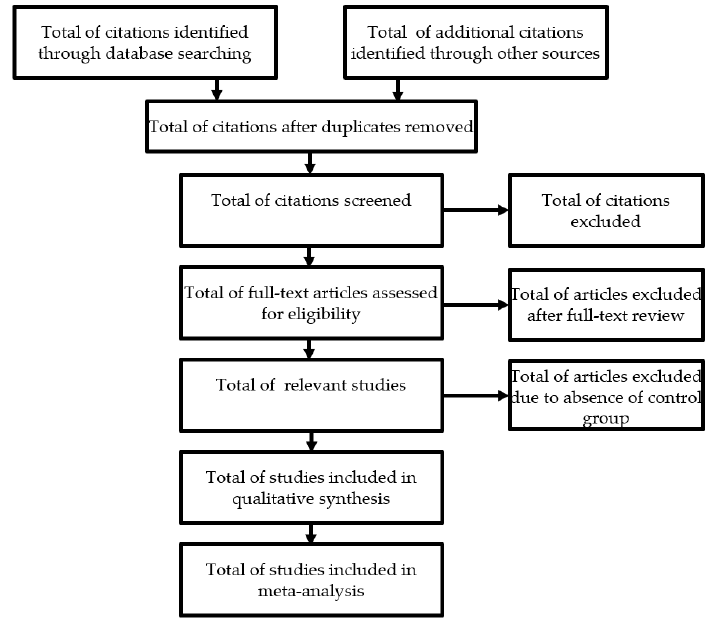
Figure 1. Flow diagram documenting inclusion and exclusion of studies.